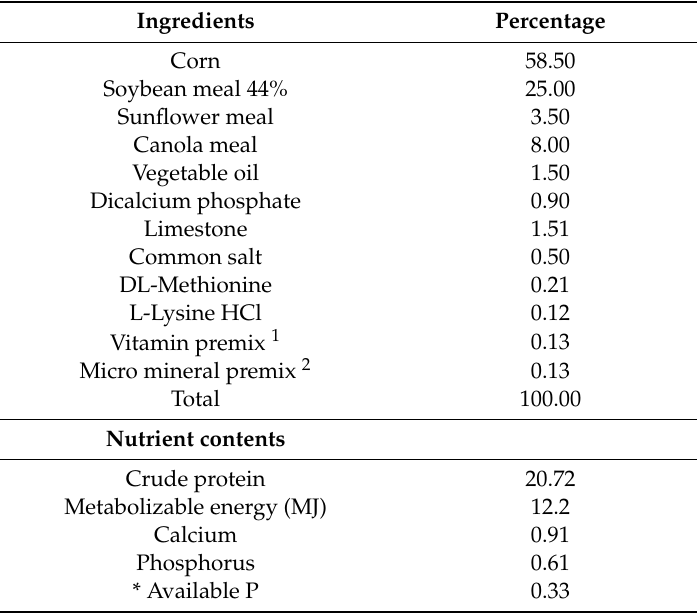
Table 1. Composition of the diet (g /